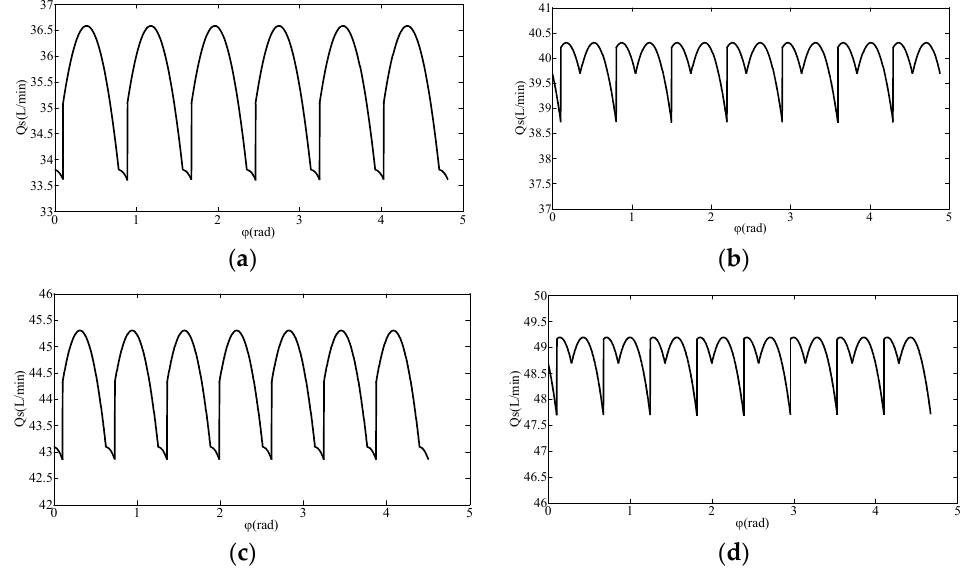
Figure 9. Actual output flow rate of piston pumps with 8~11 pistons for Δφ/2 = φ 0 = 3°. ( a ) output